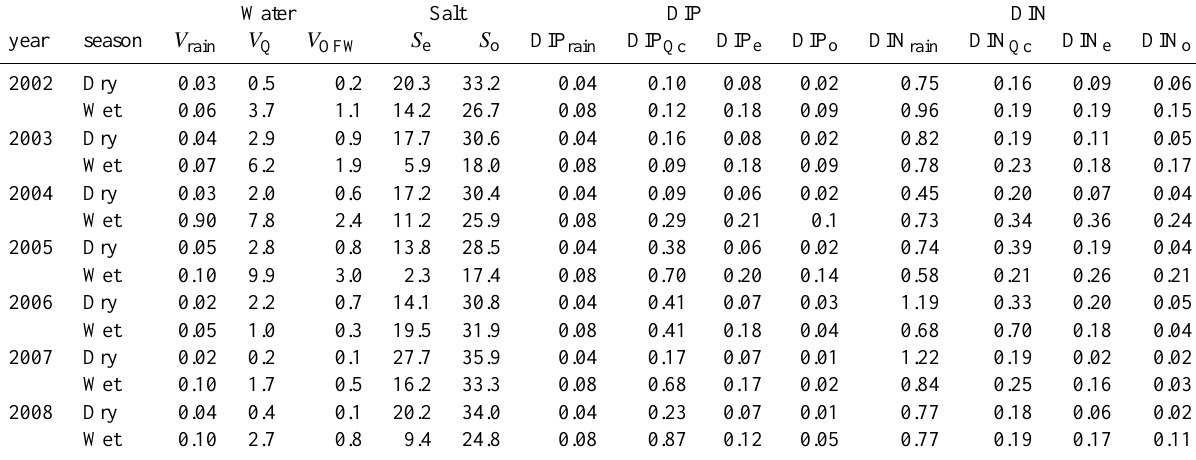
Table 3. Inputs for seasonal DIN and DIP budgets for the SLE. Values are seasonal averages from 2002 to 2008 for water, salt, DIN, and DIP budgets. The wet season consisted of months 6–11 (June–November) within each year. The dry season consisted of month 12 (December) from the preceding year followed by the first 5 months (January–May) of the next year. Abbreviations and units shown for average daily input of rain ( V rain ; 10 6 m 3 d − 1 ) , upstream flow or discharge ( V Q ; 10 6 m 3 d − 1 ) , and other freshwater sources ( V OFW ; 10 6 m 3 d − 1 ) ; salinity in the estuary ( S e ) and downstream or ocean boundary ( S o ); and concentrations of DIN and DIP in rainfall (DIN rain and DIP rain ) , discharge (DIN Qc and DIP Qc ), the estuary (DIN e and DIP e ), and the ocean boundary (DIN o and DIP o ). All concentrations are in gm − 3 . DIN and DIP in other freshwater sources (DIN OFW and DIP OFW ) were assumed to be equal to DIN Qc and DIP Qc . See text for specifics and sources